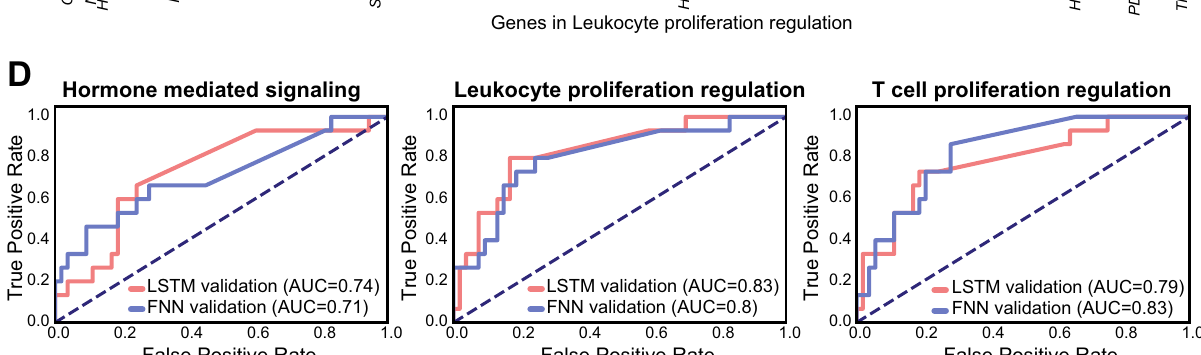
Fig. 1 | Nonlinear classi fi ers enhance the prediction performance of melanoma ICI response based on mutations within biological processes. A Bar plot showingtheRFvalidationperformancesfortopprocess-basedmutationclassi fi ers. Thedashedlinesindicaterandomperformance(thickline)andtheperformanceof the tumor mutation burden (thin line). B ROC curves demonstrating the RF vali- dation performance when using mutations within leukocyte-proliferation regula- tionprocess(upperpanel)andwithintheT-cellproliferationprocess(lowerpanel). C The genes selected by different trees in the RF model that is trained using